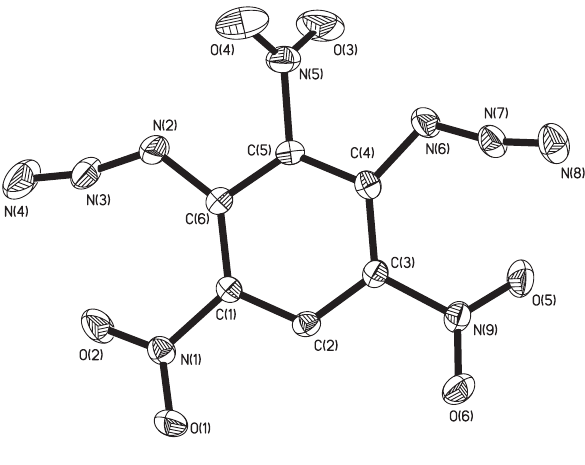
Table 1: Data collection and handling.